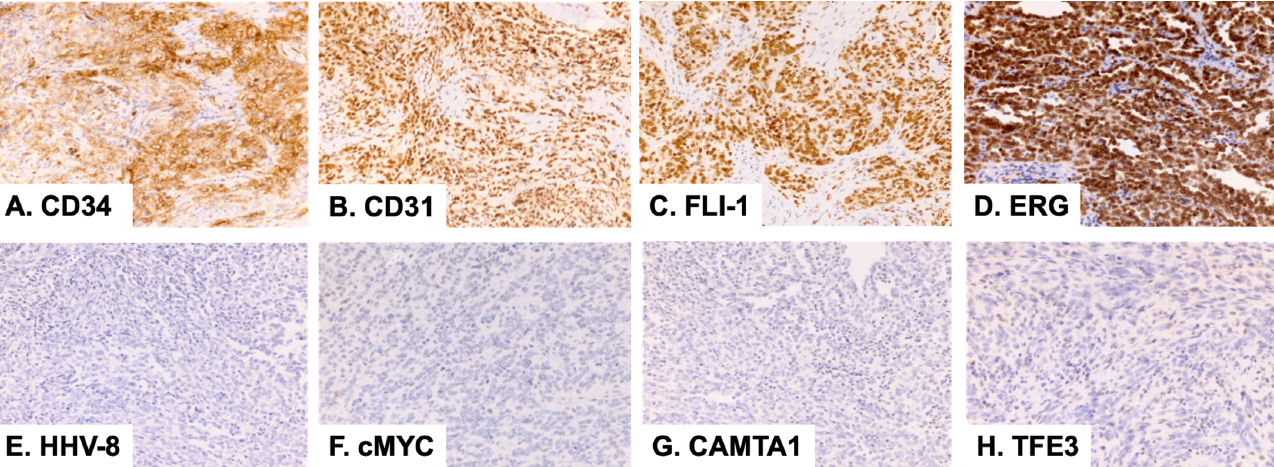
Figure 1. Morphologic features of the three lesions at 40× and 200× magnification. ( A , D ) Primary lesion in 2008 with admixture of retiform and epithelioid patterns and rare MFs. ( B,E ) First recurrent lesion in 2015 with increase in cellularity and cytologic atypia and 8 MFs/10 HPF. ( C,F ) Second re- current lesion in 2017 with pleomorphism, prominent nucleoli, and >10 MFs/10 HPF.